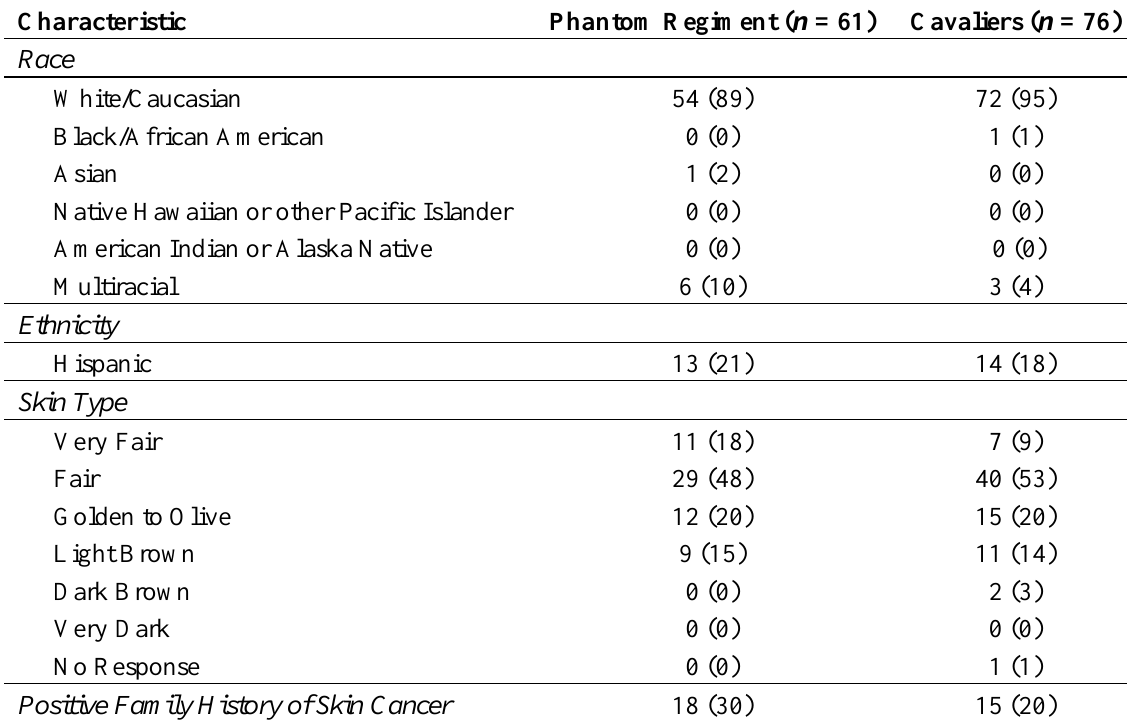
Table 1. Participants Baseline Demographic Characteristics.